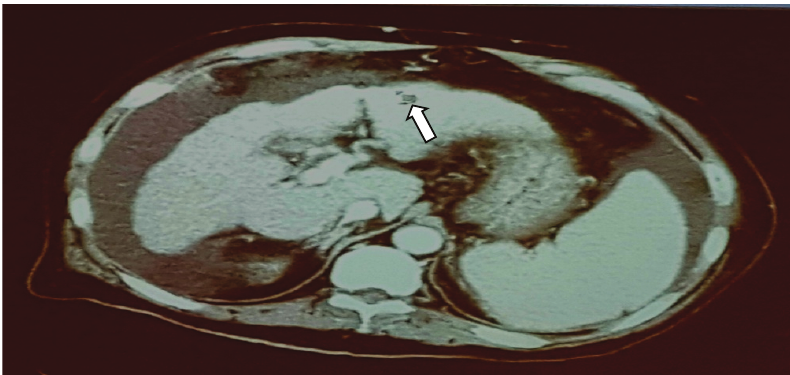
Figure 1: Contrast-enhanced CT scan image of small HCC nodule in cirrhotic